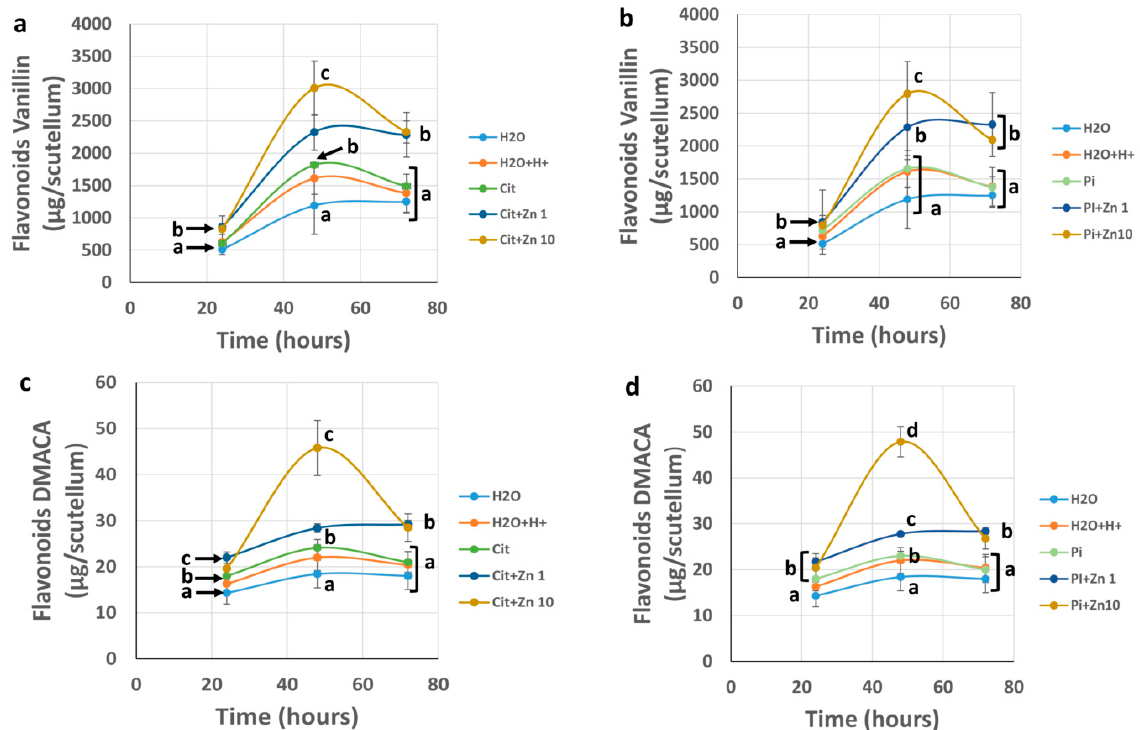
Figure 7. Concentration of phenolic compounds in the scutellum during germination. The concentration of phenols in the scutellum from embryos imbibed for 24, 48, or 72 h in H 2 O, H 2 O+H + , Pi, Cit, or Zn1, Zn10, or Zn50 dissolved in Cit or Pi buffer quantified ( a , b ): with the vanillin method; ( c , d ): with the DMACA method. ANOVA was performed, followed by the Tukey–Kramer multiple comparison test, with p < 0.05 representing significance. The different lowercase letters imply significant differences among experimental conditions for specific imbibition times. The data represent the mean ± SE of 3 to 6 independent assays.